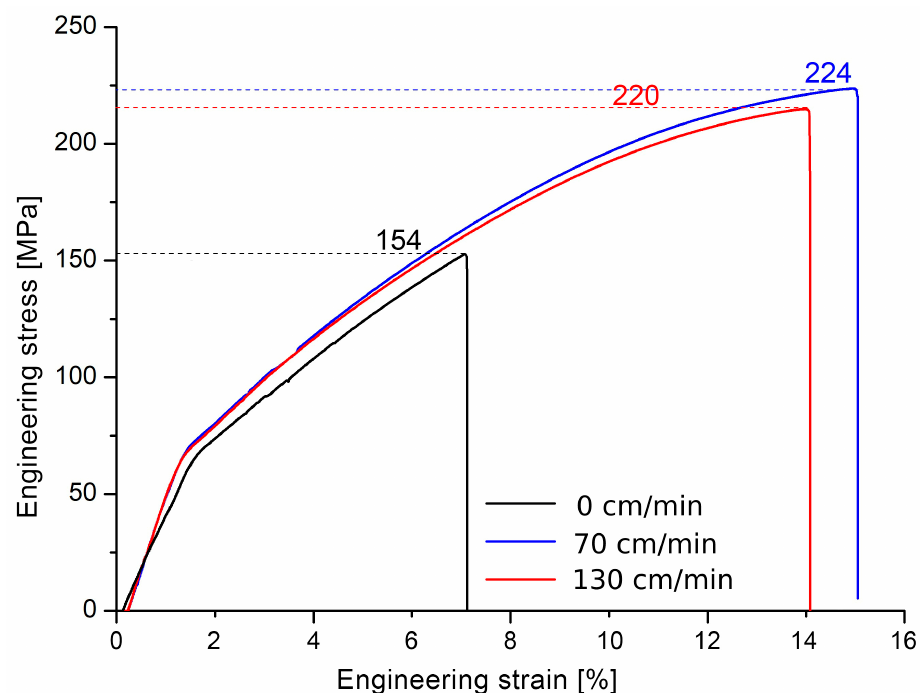
Figure 15. Stress–strain curves for weld joints created at filler wire feed rates.